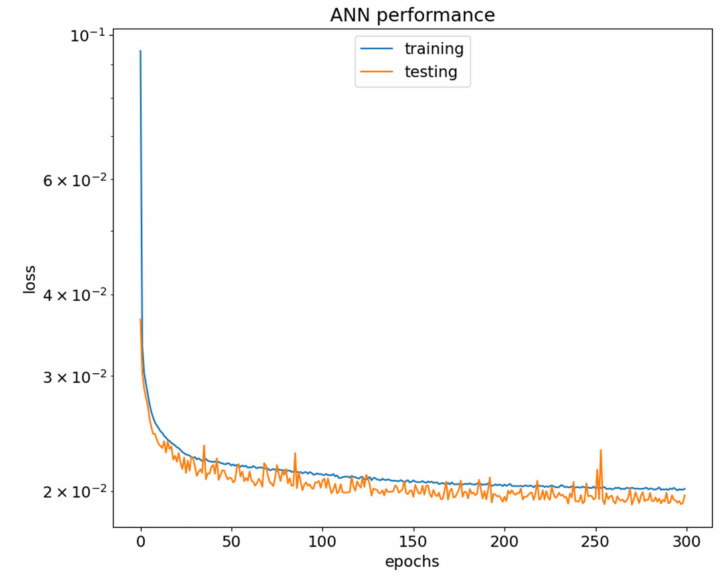
Figure 4. Performance of training the ANN for 300